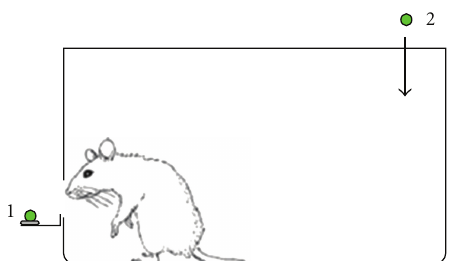
Figure 1: The rat reach-grasp-retrieve (RGR) task. The rat is allowed to make one controlled reach for the food pellet seen at position 1. The rat must reach through a slot that is large enough for his hand, but not his mouth or whiskers. The rat must then walk to the back of the chamber where they may receive a second food pellet. Walking to the back of the cage is necessary in order for a new food pellet to be placed at position